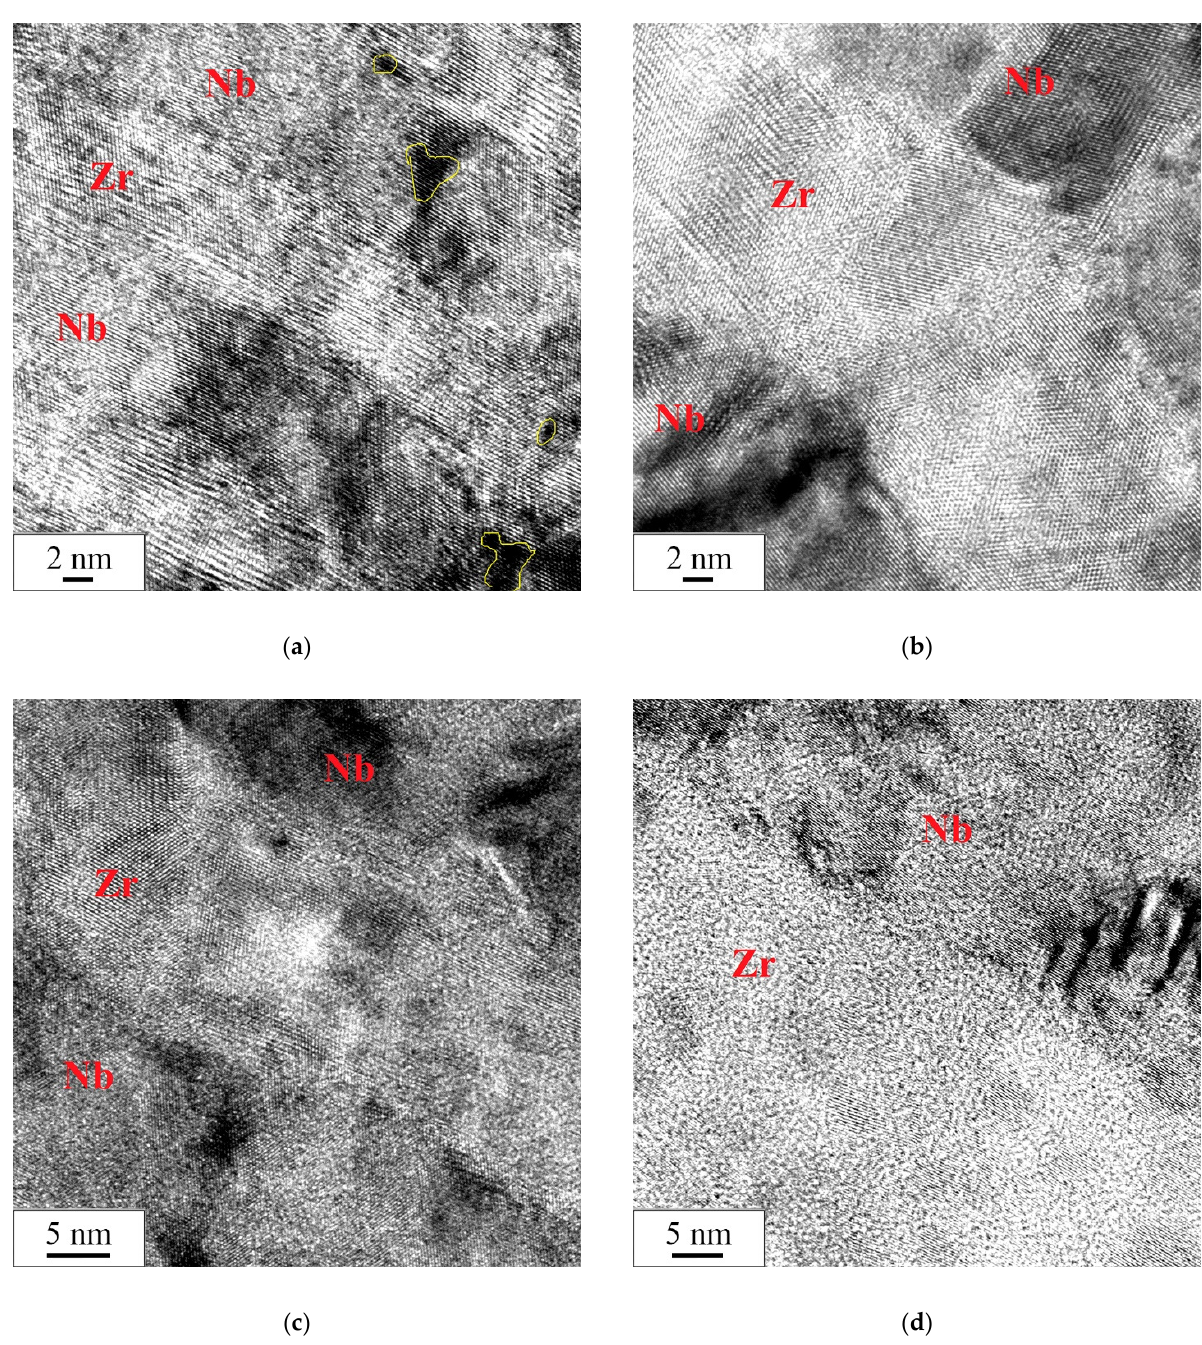
Figure 4. The high-resolution TEM images of the microstructure of the Zr/Nb NMC cross-section after radiation: ( a ) Zr/Nb 10/10, ( b ) Zr/Nb 25/25, ( c ) Zr/Nb 50/50, and ( d ) Zr/Nb 100/100.